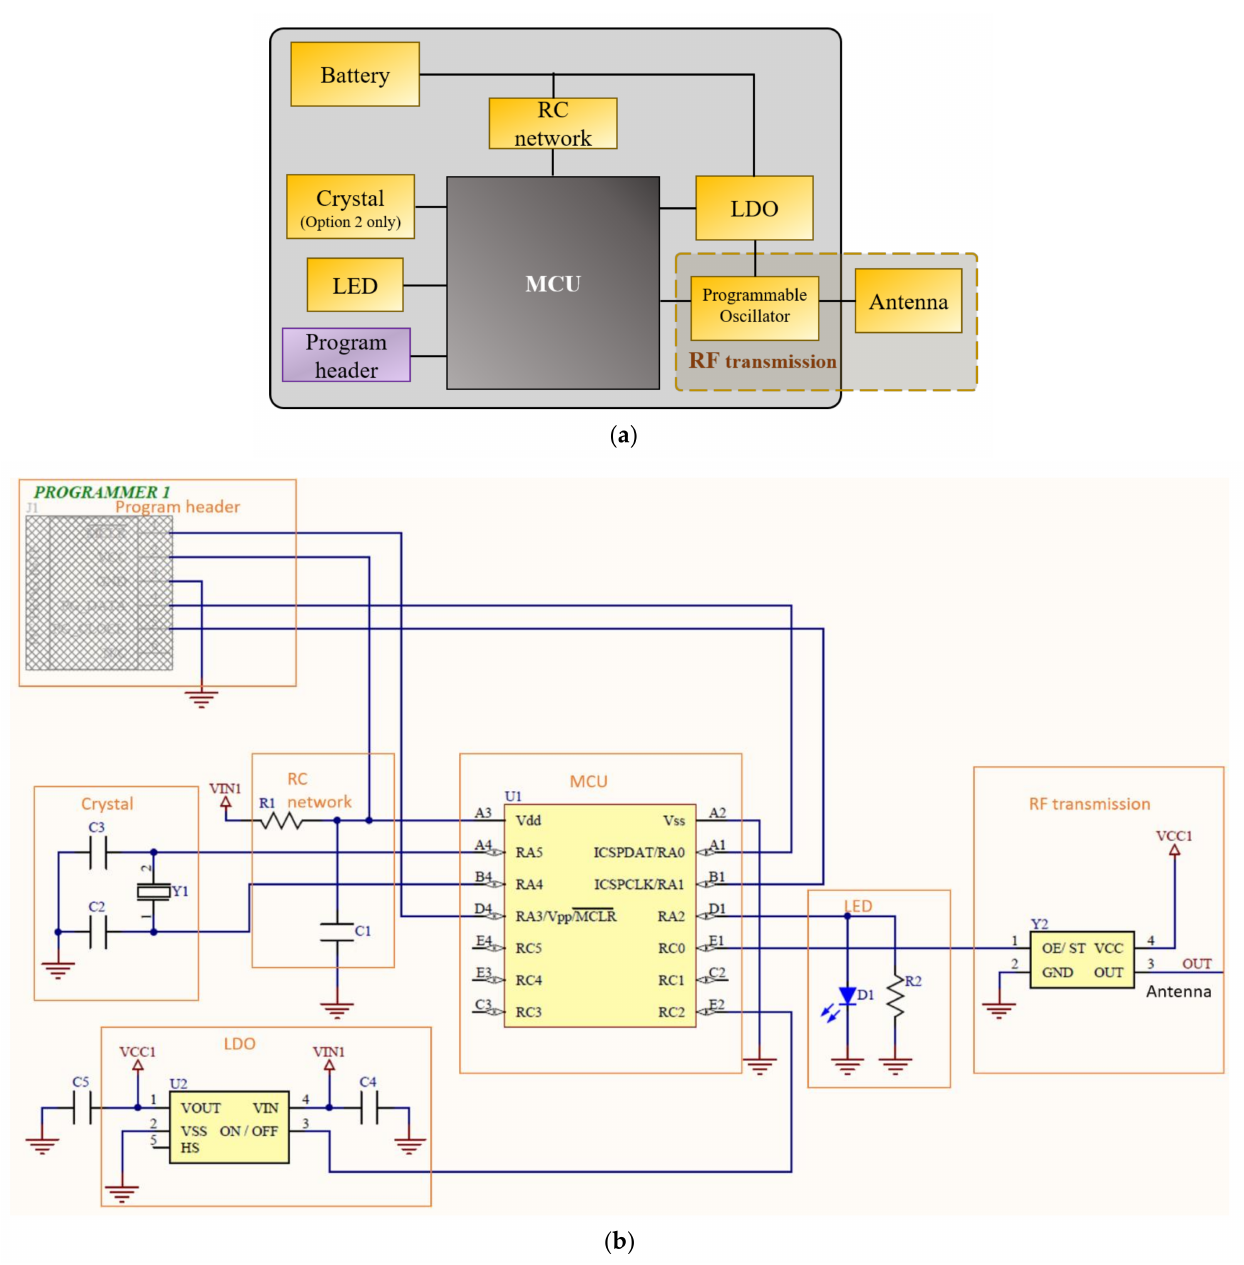
Figure 1. Schematic illustrations of the RF transmitter circuit design: ( a ) circuit diagram; ( b ) circuit